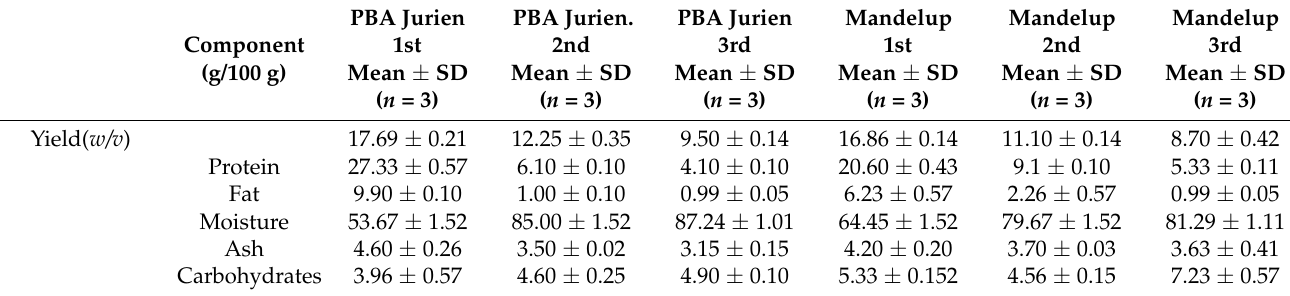
Table 5. Physico–chemical characterization and mean yield of cheese lupin from split lupin milk; first, second, and third filtrations of two cultivars of L.